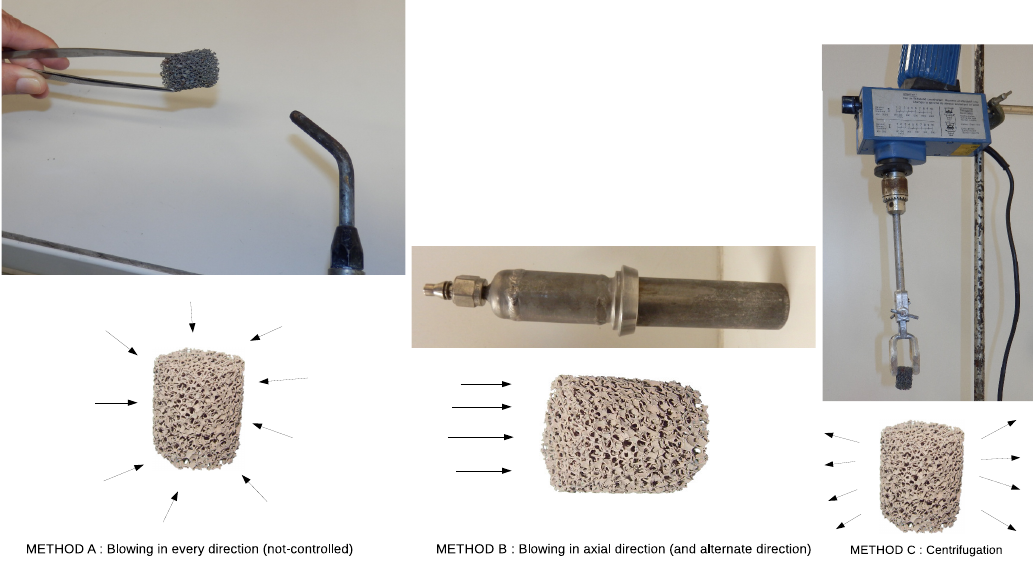
Figure 1. Methods to evacuate the excess of suspension.